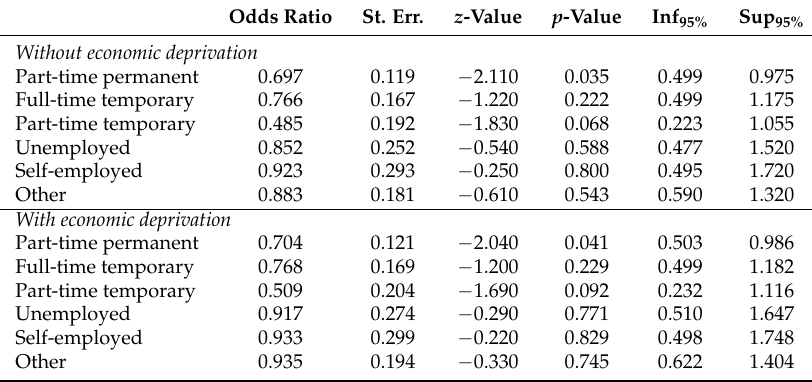
Table 7. Correlated random-effects ordered logit model: estimated odds ratios for employment status (ref.: Full-time permanent)—Northern countries. Odds Ratio St. Err.